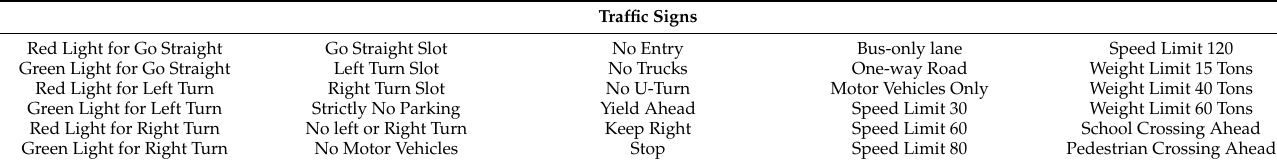
Table 2. Categories of traffic signs.